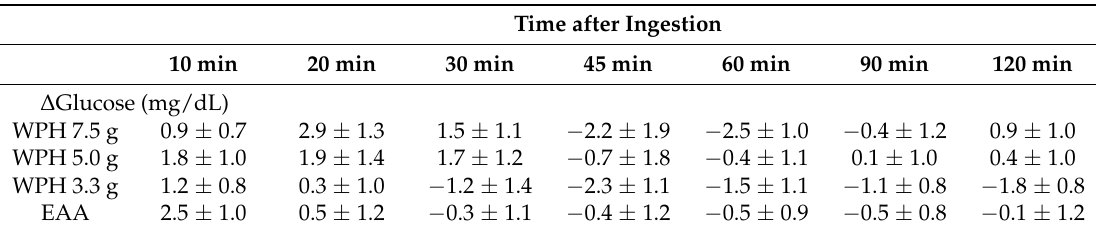
Table 3. The changes from baseline of plasma glucose concentrations 1